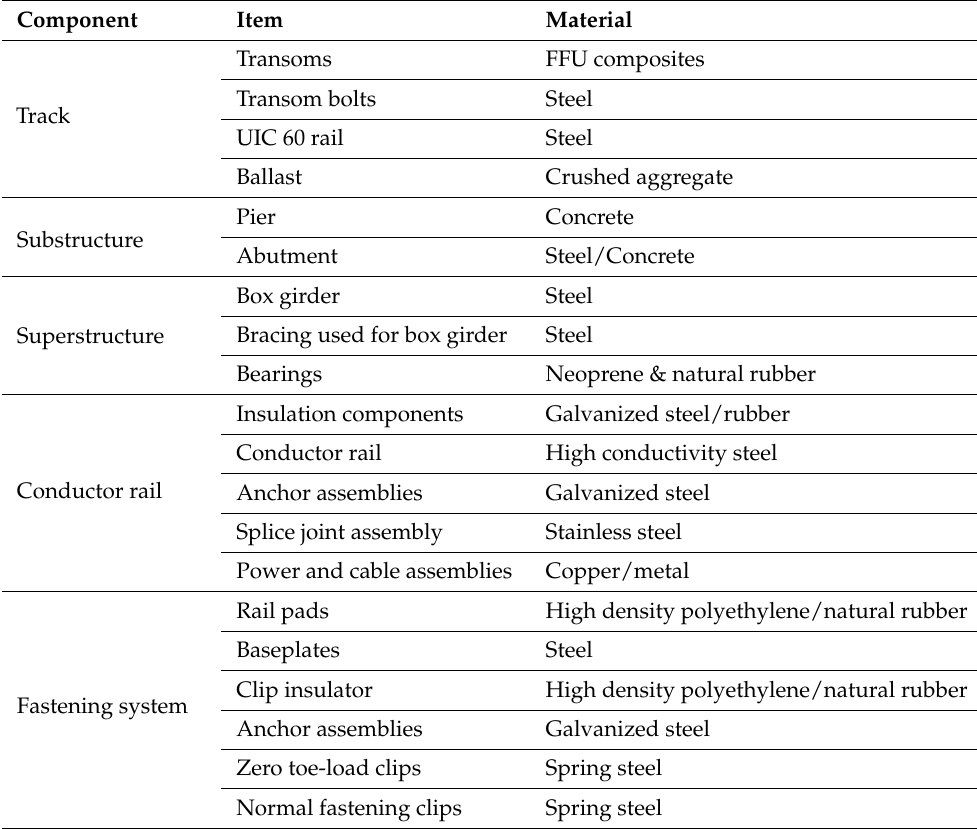
Table 5. The material list for the Minnamurra Railway Bridge.